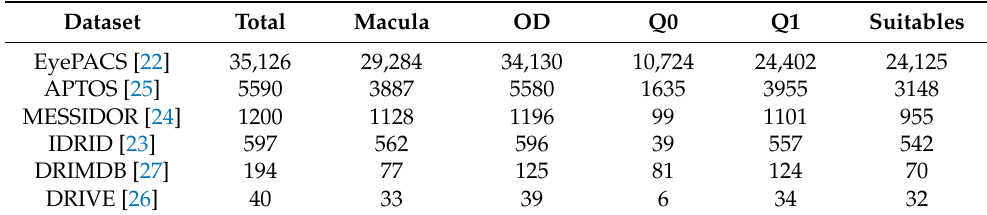
Table 10. Number of suitability for each public dataset. Number of images where the Macula and Optic Disk (OD) are detected. The low-quality (Q0) and high-quality (Q1) RFI images.